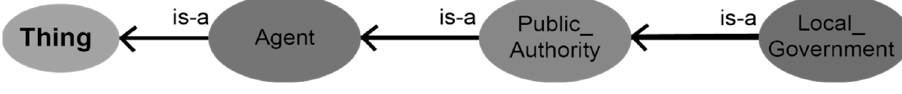
Figure 5. Action concept.